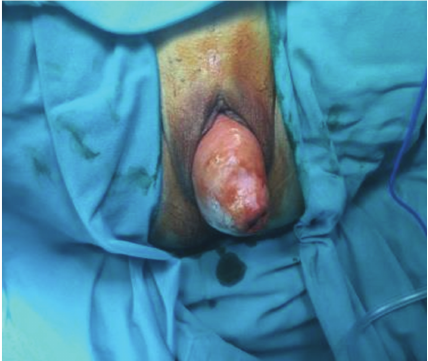
Figure 1: Preoperative findings of the patient with total pelvic organ prolapse with anterior-posterior and apical prolapse (grade